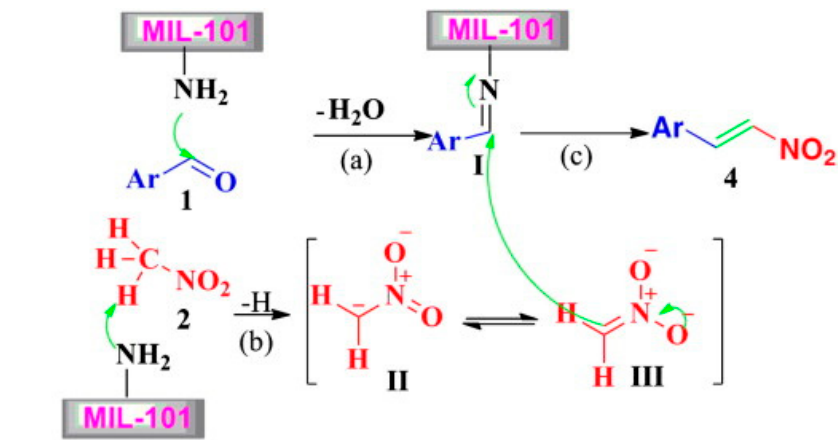
Figure 4. Proposed mechanism for the activation of benzaldehyde and nitromethane at the amino groups of MIL-101 metal-organic framework. Reprinted with permission from.44 Copyright (2012) Elsevier.